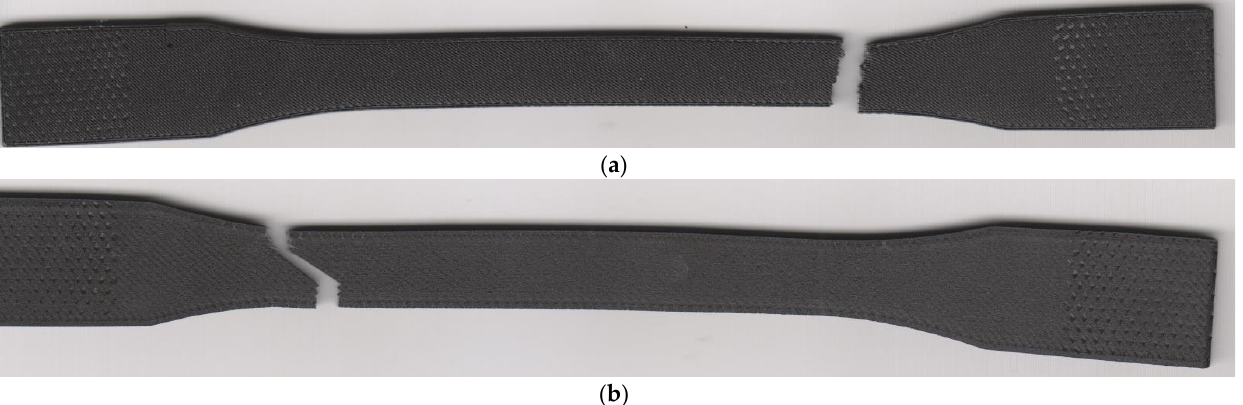
Figure 24 . Fractured specimens: ( a ) 10 floor/roof laminas (epsilon series); ( b ) 0 floor/roof laminas (eta series).